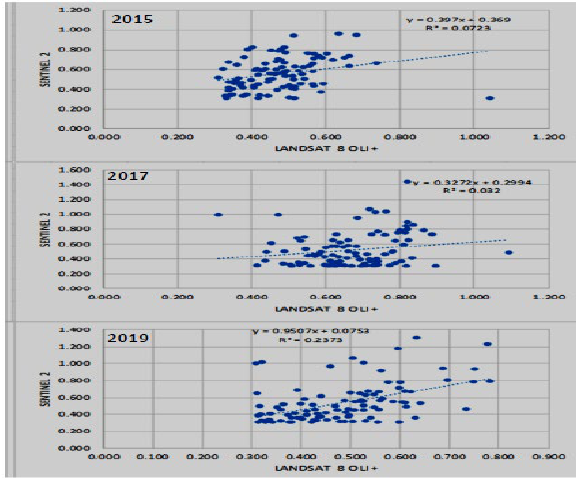
Table 9: Coefficient of Determination (R 2 ) and Correlation Coefficient(r) Values for Landsat8 and Sentinel 2A